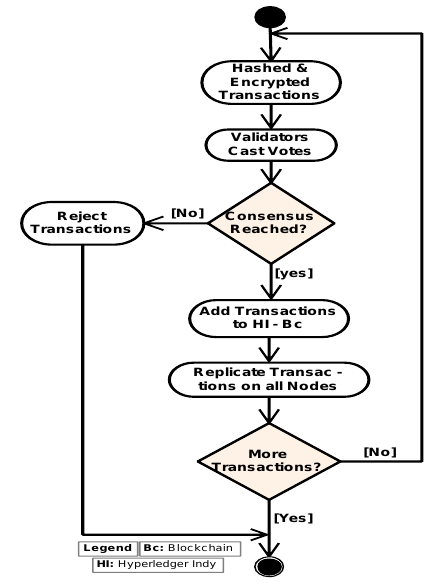
Fig. 8. Activity flow diagram for Blockchain Operations in the